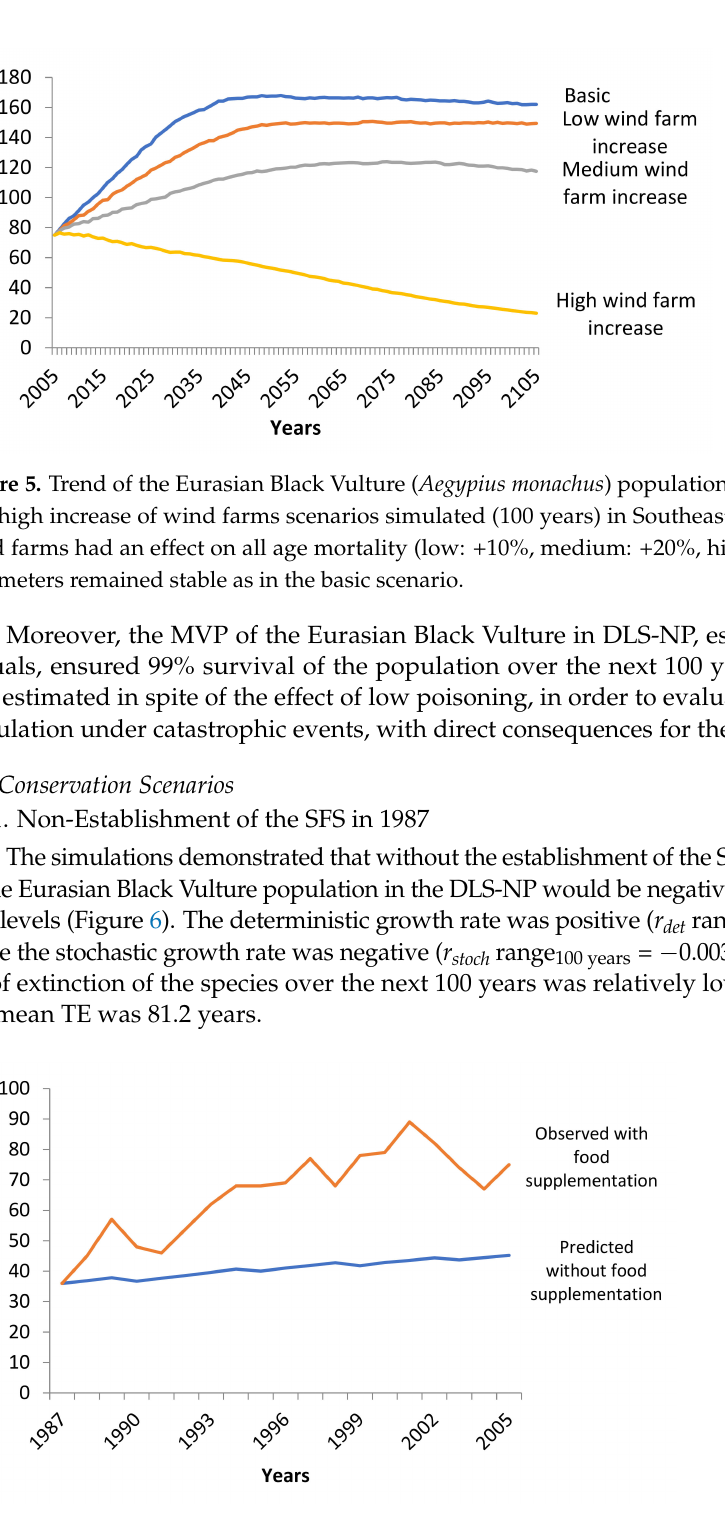
Figure 6. Observed population trend of the Eurasian Black Vulture ( Aegypius monachus ), under supplementary feeding in the Dadia-Lefkimi-Soufli Forest National Park [21,37], and the predictive trend of the population under the scenario of non-establishment of the supplementary feeding site, during the years 1987–2005. The initial population size was 36 individuals; the carrying capacity (K) was set at 100 ± 10 standard deviation in K due to environmental variability. The percentages of breeding females at low density P(0) and at carrying capacity P(K) were estimated as 47.5% and 27.81%, respectively, and the environmental variation in reproduction was calculated to 5%. All other parameters remained stable as in the basic